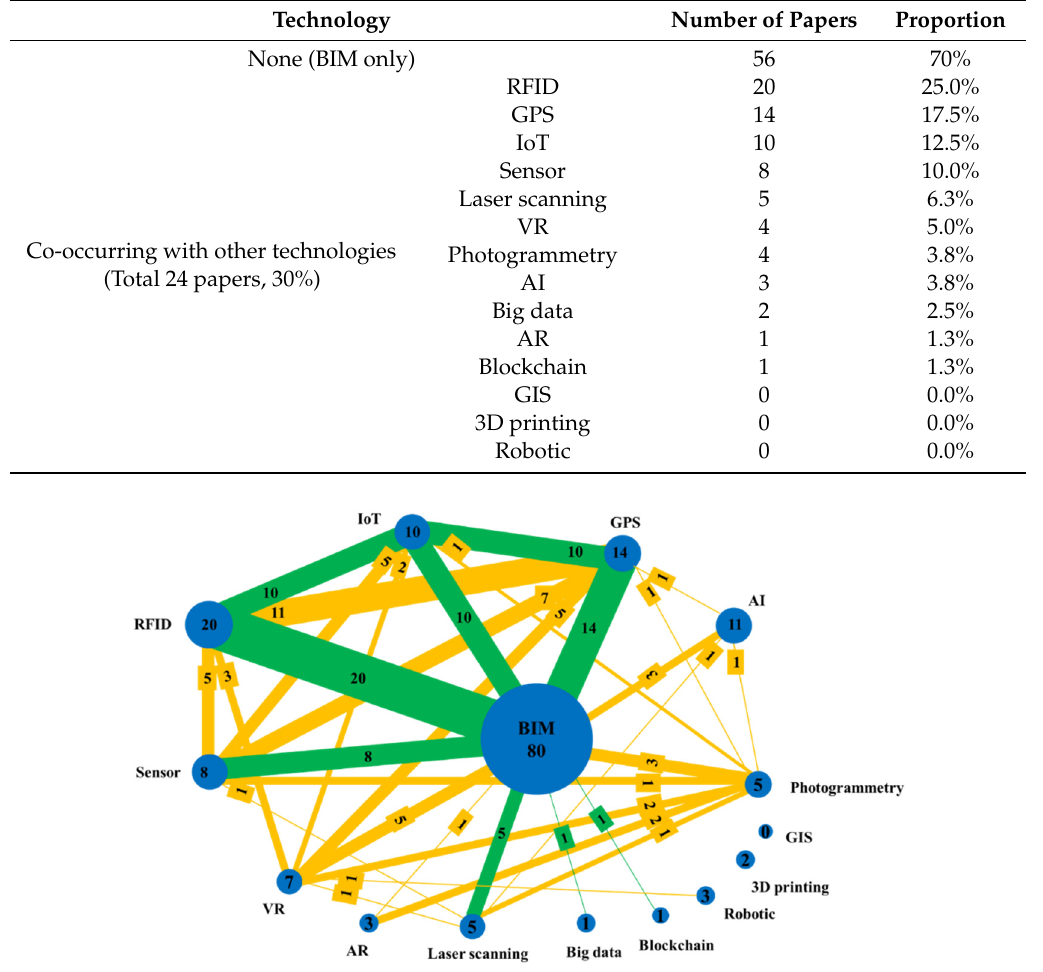
Figure 8. Mapping results of relationships among digital technologies.